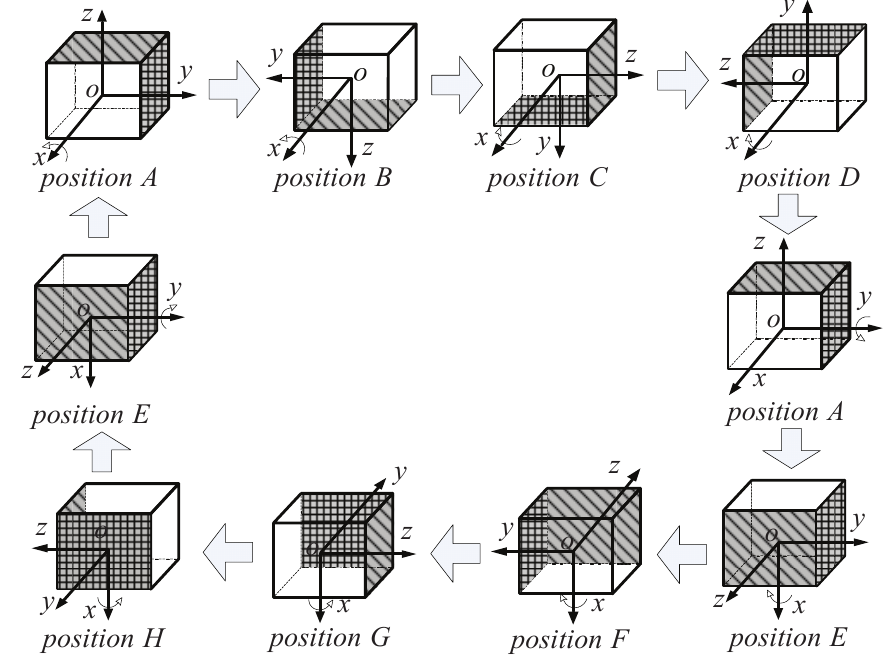
Figure 1. The eight-position rotation scheme: The proposed initial alignment and self-calibration method in dual-axis rotary SINS with eight different positions in which to reside and rotating about the x axis and y axis.